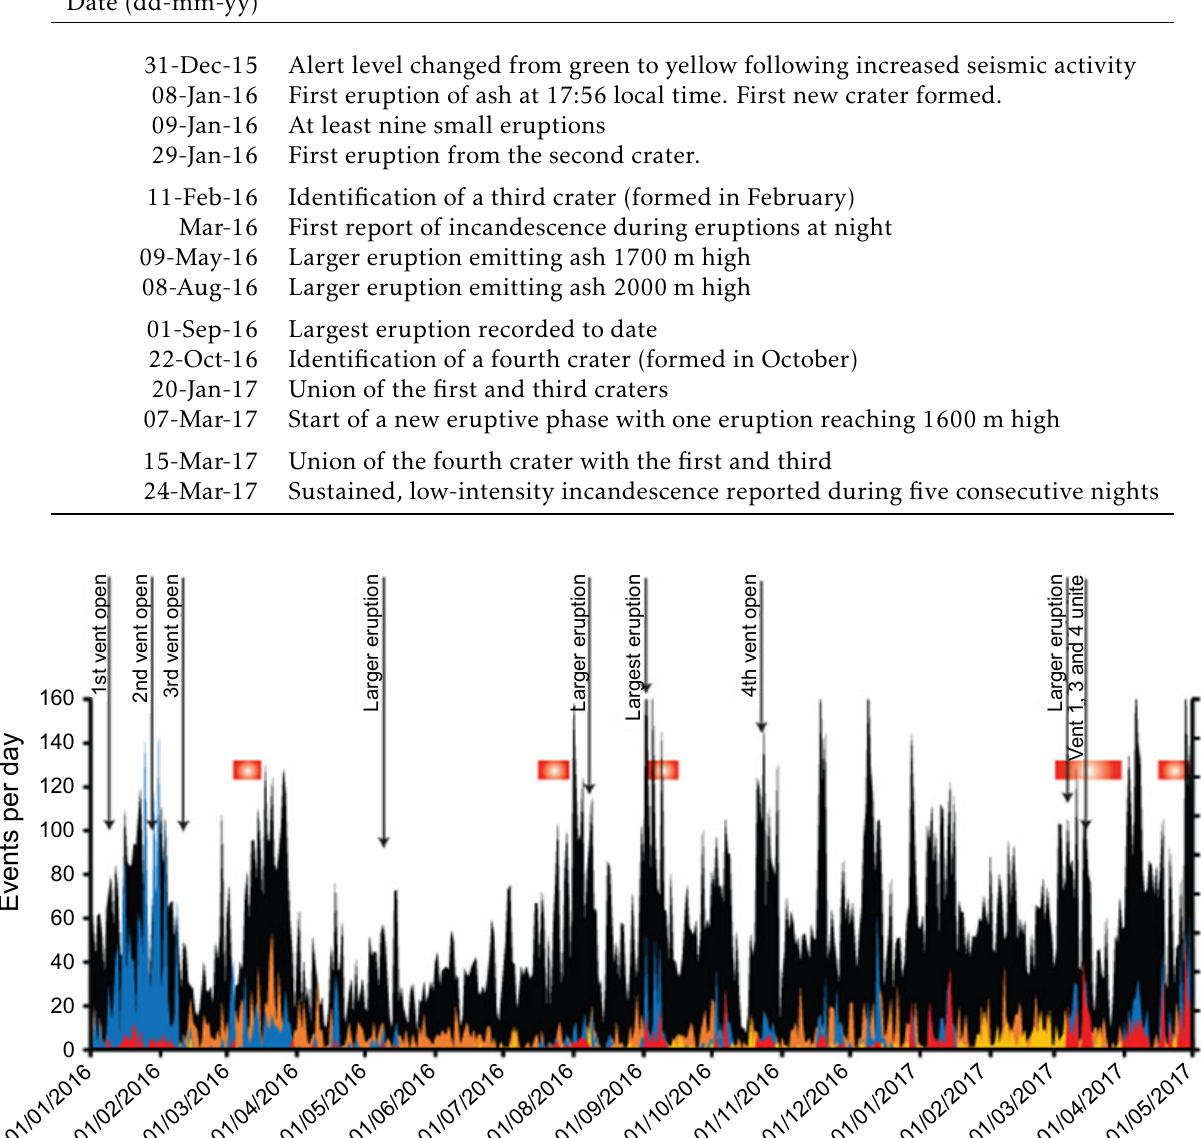
Table 1 – Chronology of the 2016–ongoing unrest and induced morphological change to the summit area.